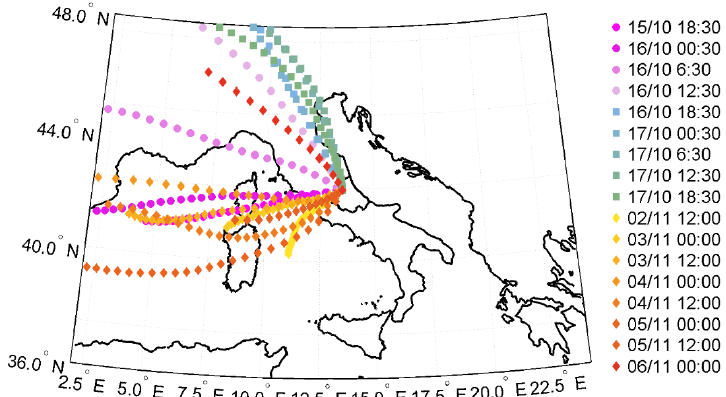
Figure 6. The Hysplit 24 h back-trajectories with as starting time the occurrence of the first and third plums (dots and diamonds, respectively) and of the second one (squares).